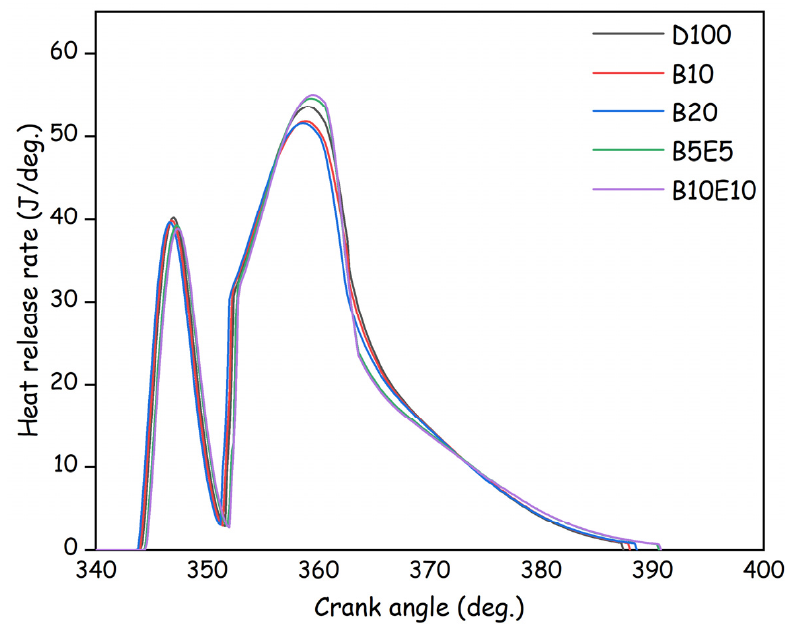
Figure 5. HRR of different fuel blends against crank angle at full load.